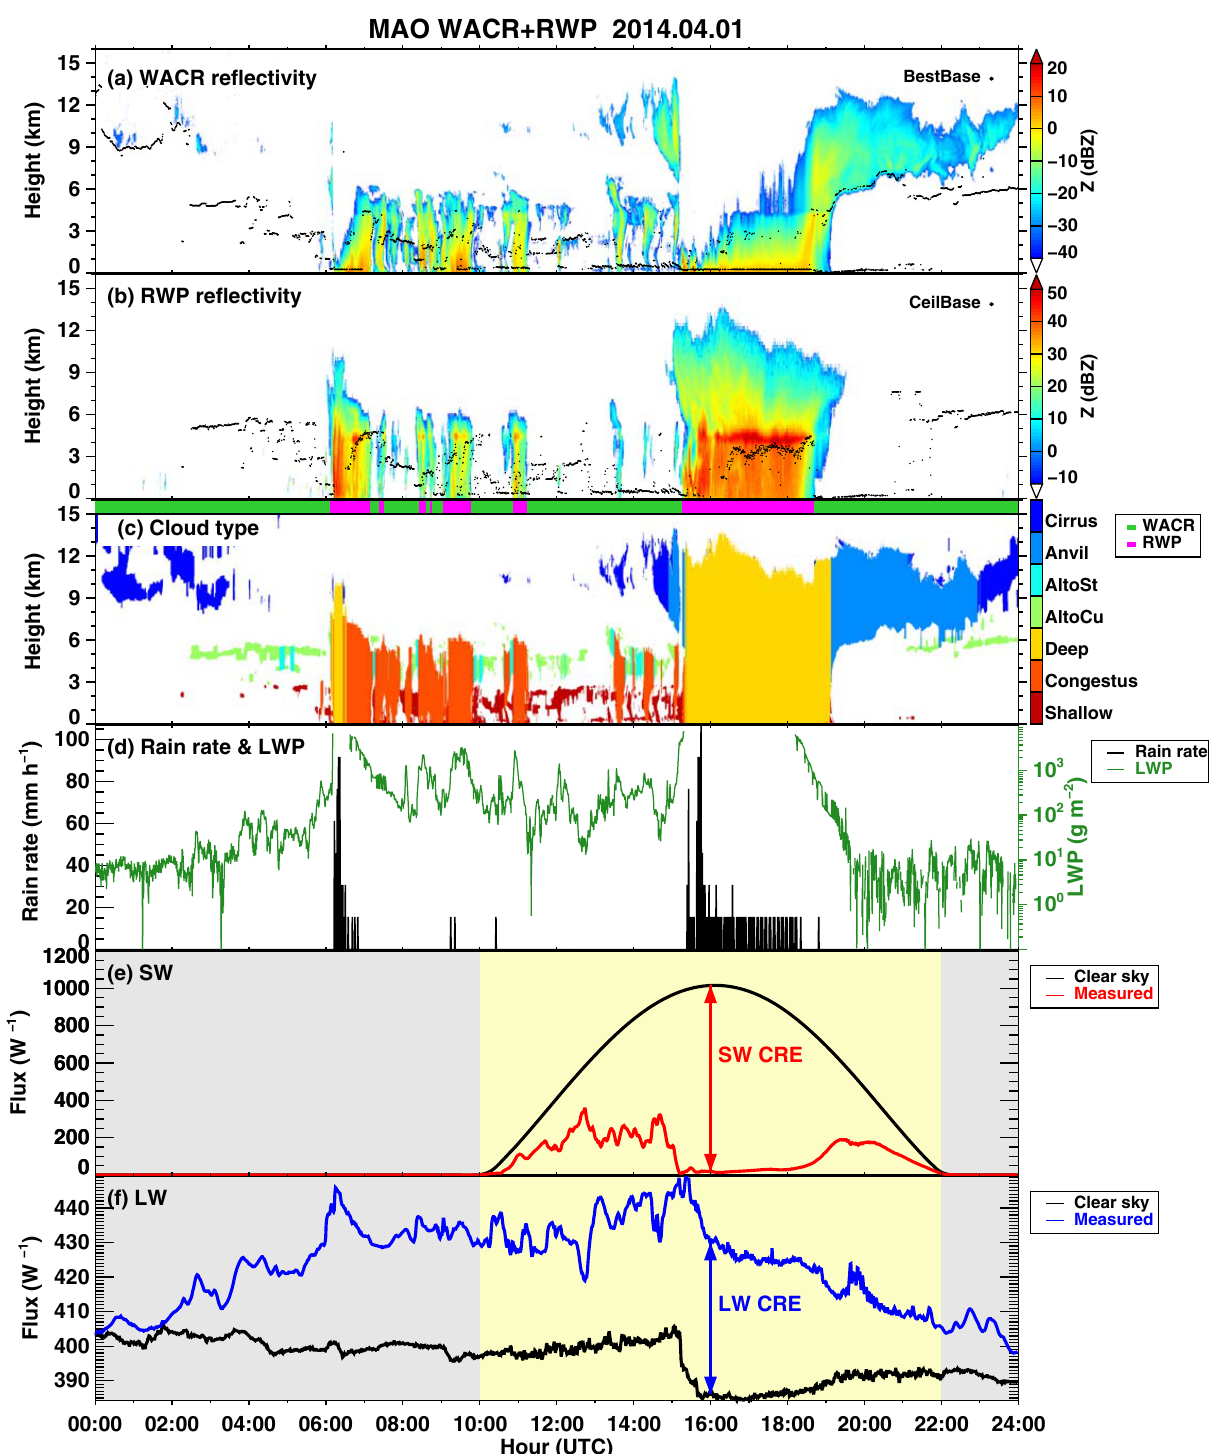
Figure 5. Example from the merged WACR-ARSCL-RWP dataset for a 1 April 2014 event: (a) WACR reflectivity, (b) RWP reflectivity, (c) cloud-type classification, (d) tipping bucket rain rate (black, 5min increments) and MWR retrieved liquid water path (green), (e) down- ward shortwave flux and (f) downward longwave flux. The black dots in panels (a, b) reflect a best estimate cloud-base height and ceilometer cloud-base height from the WACR-ARSCL dataset. Magenta bars above panel (c) show periods when RWP data were used to replace WACR data (green bars). The black lines in panels (e, f) reflect clear-sky flux estimates from the radiative flux analysis product. The differences between clear-sky estimated fluxes and measured fluxes (denoted between the arrows in panels (e, f) ) are defined as cloud radiative